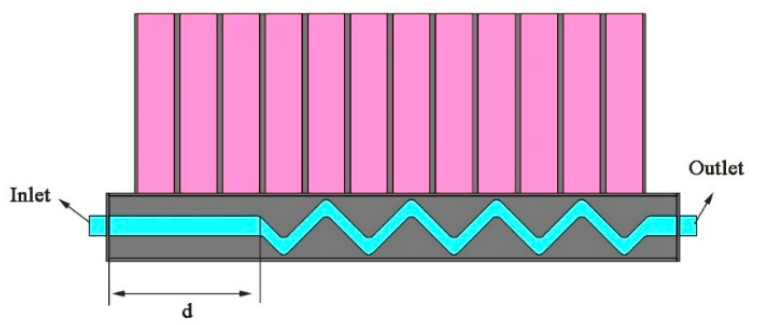
Figure 8. Schematic diagram of composite channel.